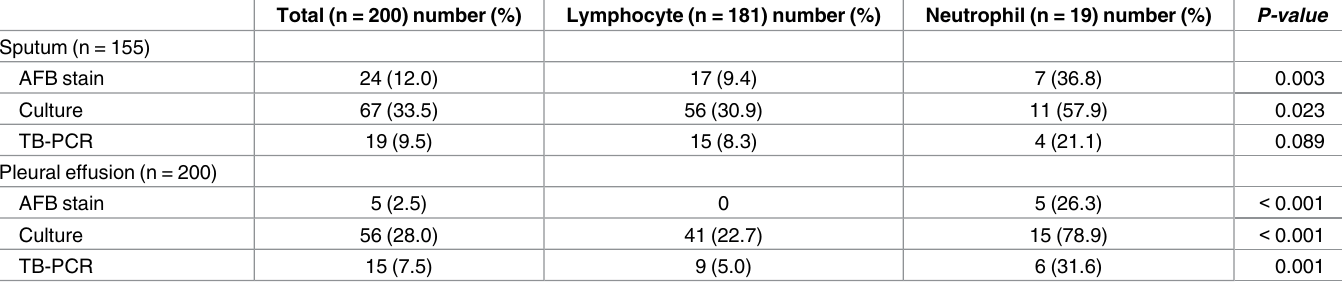
Table 3. Microbiological Characteristics of Lymphocyte- and Neutrophil-Predominant Pleural TB.